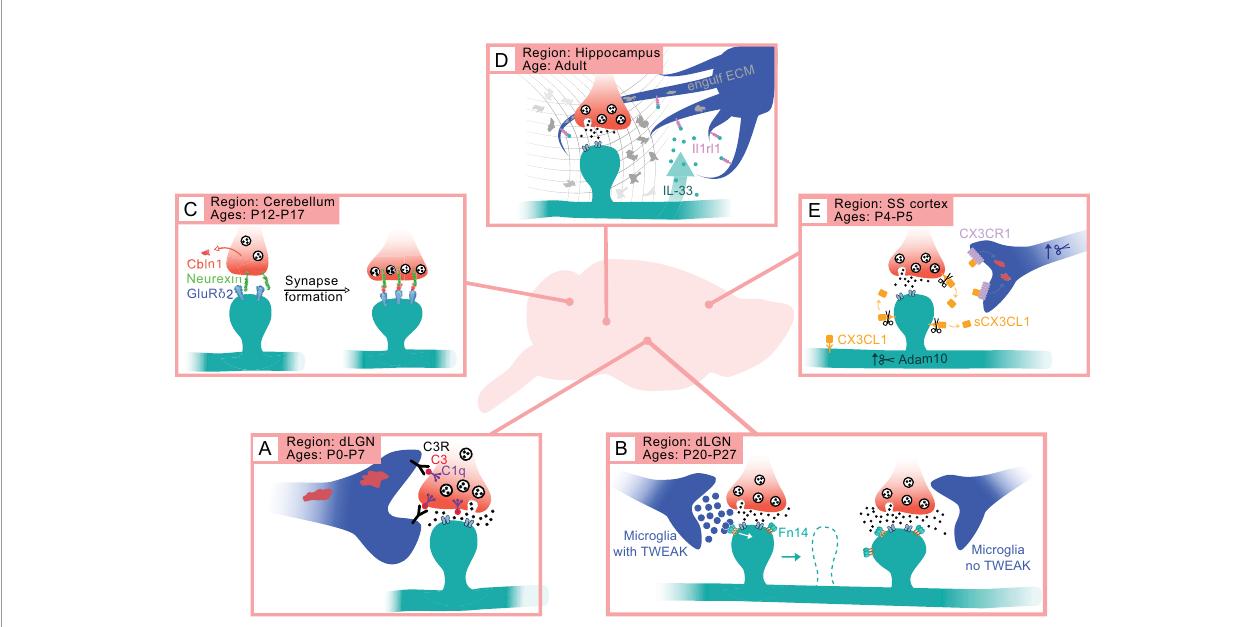
FIGURE 2 | Cytokine pathways coordinate brain development and plasticity in a region- and age-dependent manner. (A) In the dLGN of the thalamus, the classical complement cascade (ccc) mediates the phagocytic engulfment of synapses (presynaptic inputs in red, postsynaptic dendrites and spines in teal) by microglia (blue) between birth and P7. (B) During a later period of experience-dependent re fi nement in the dLGN, TWEAK-Fn14 signaling from microglia to neurons disassembles synapses, while Fn14 functions in the absence of its ligand TWEAK to strengthen synaptic connections. (C) In the cerebellum, the cytokine Cbln1 binds presynaptic Neurexin and the postsynaptic neurotransmitter receptor GluR d 2 to establish parallel fi ber – to – Purkinje cell synapses independently of microglia. (D) IL-33 to Interleukin 1 receptor-like 1 signaling mediates experience-dependent synaptic plasticity in the hippocampus by inducing microglia to engulf the extracellular matrix. (E) Fractalkine signaling from neurons to microglia establishes somatosensory whisker territories via microglial engulfment of thalamocortical